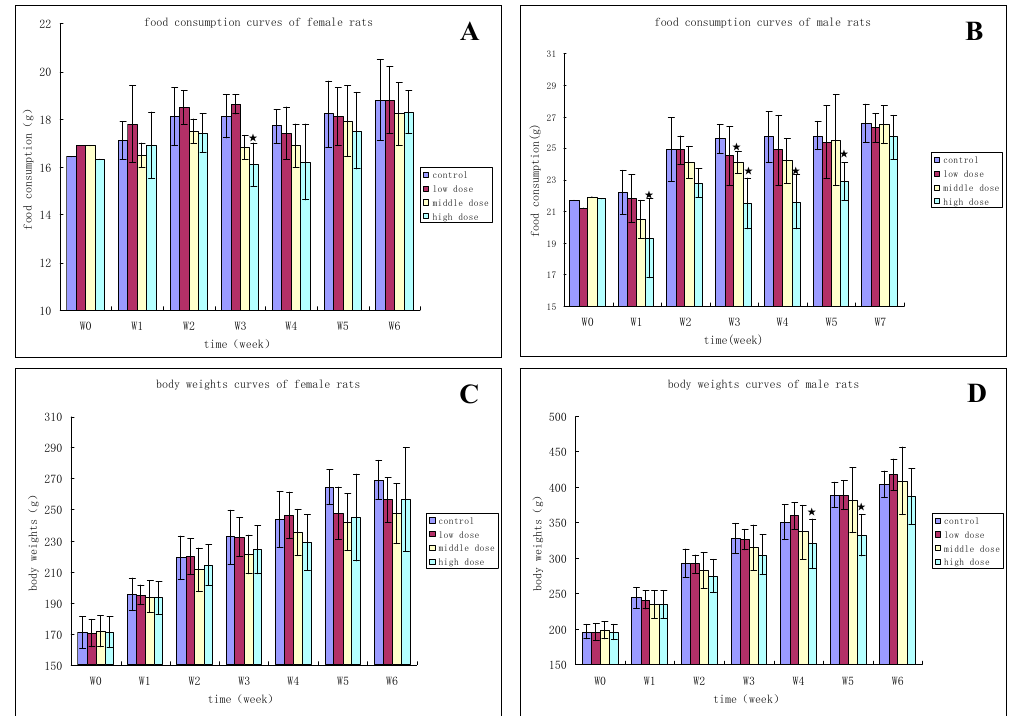
Figure 8. ( A ) Food consumption curves for female rats given HZ1006 for 28 days followed by a 14-day recovery; ( B ) Food consumption curves for male rats given HZ1006 for 28 days and followed by a 14-day recovery; ( C ) Body weight curves for female rats given HZ1006 for 28 days and followed by a 14-day recovery; ( D ) Body weight curves for male rats given HZ1006 for 28 days and followed by a 14-day recovery. ★ p < 0.05, compared with control group.